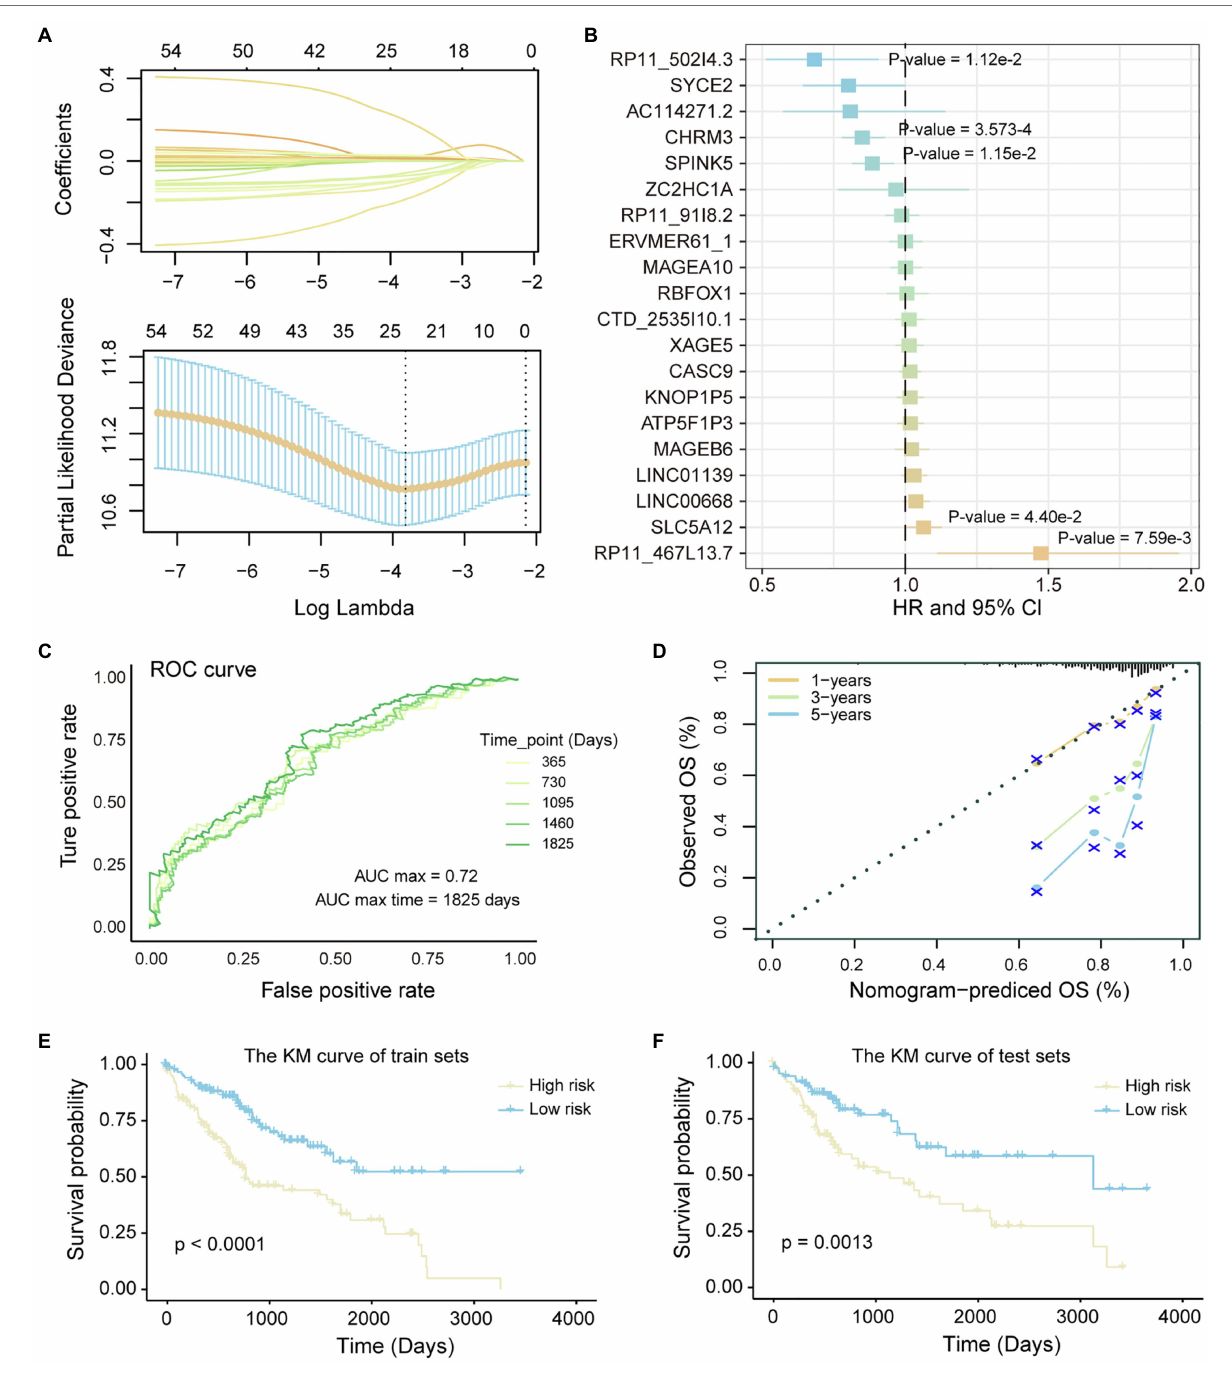
FIGURE 4 | Identification of potential prognostic markers of LIHC. (A) Lasso regression model screen genes related to overall survival (OS) of LIHC patients. Variation curve of regression coefficient and λ value is shown. (B) COX risk regression to assess the association between the expression level of genes and patient survival. Genes that are significantly related to patient survival are added value of p . (C) The ROC curve reflects the predictive power of the risk regression model at five time points from 1 to 5 years. The different colored curves represent specific time points. (D) Calibration curve of nomogram. (E,F) Kaplan–Meier (KM) curves for survival of train set and test set in high- and low-risk groups. Log-rank test was used to calculate statistical